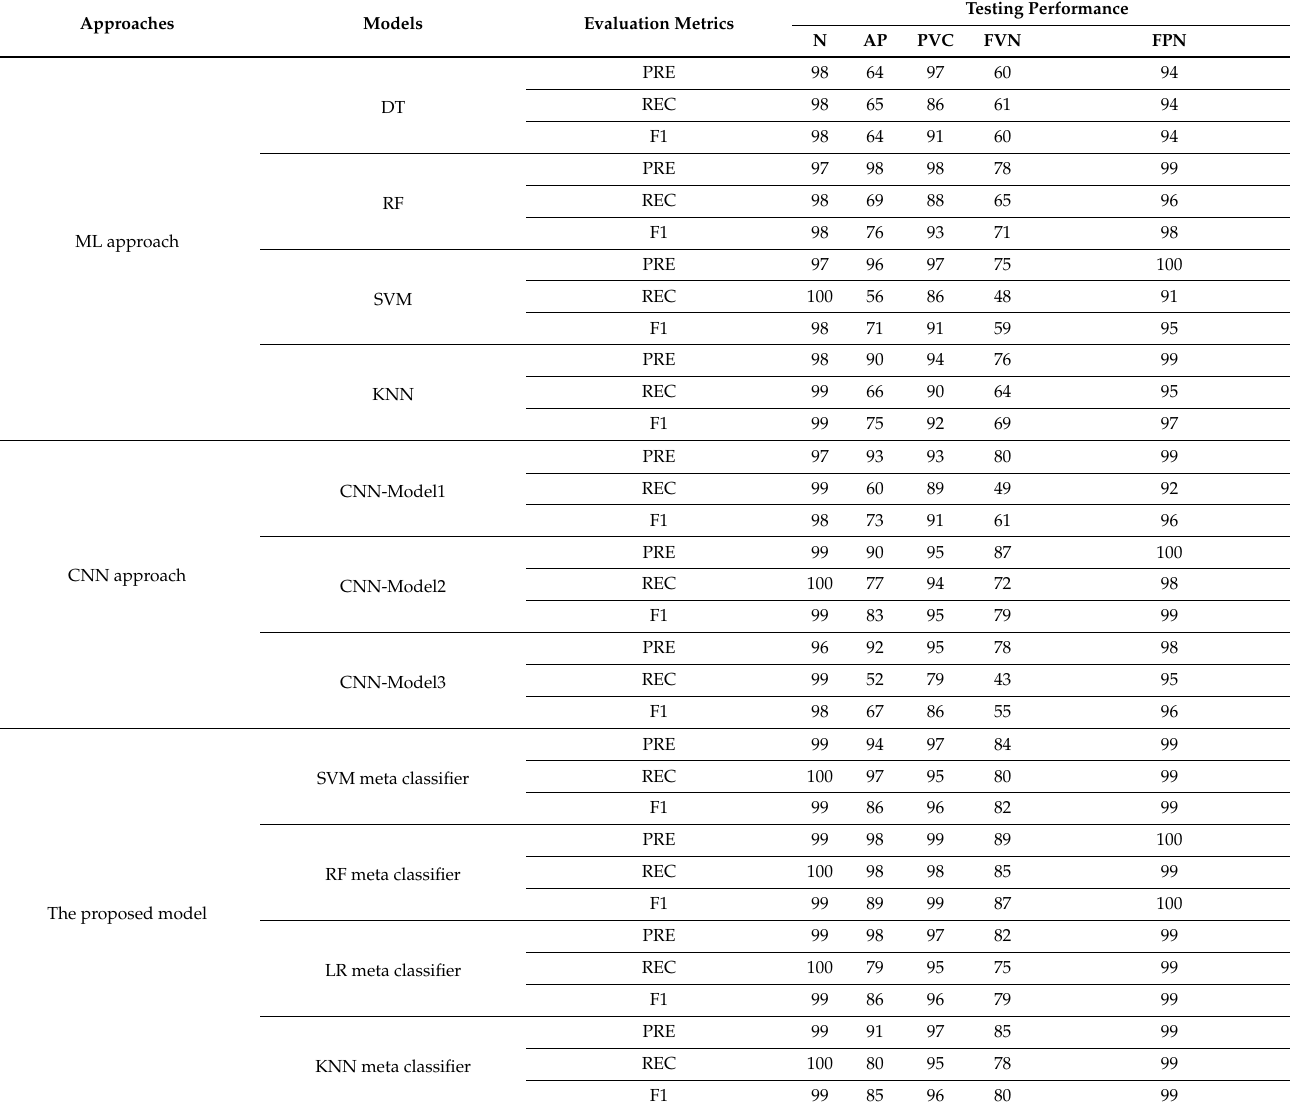
Table 4. The average ACC, PRC, REC, and F1 when applying the models to the MIT-BIH